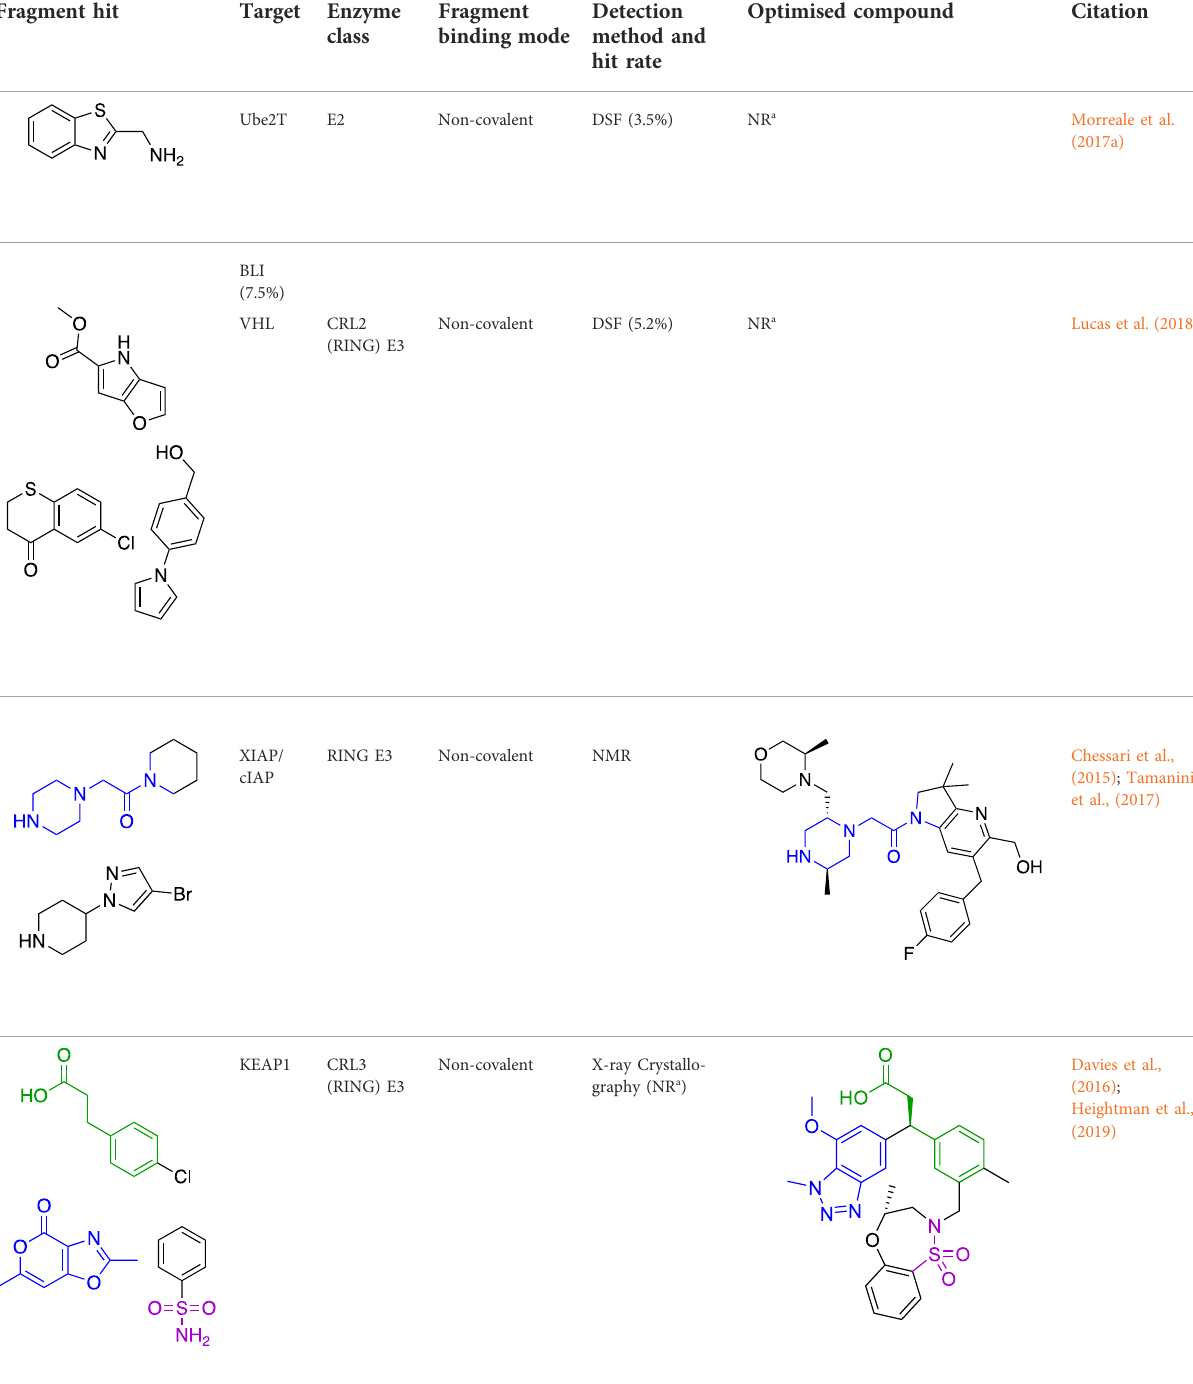
TABLE 1 Summary of fragment hits and fragment-derived modulators of ubiquitin system proteins. Pharmacophores from original fragment hits which were retained in optimised compounds are highlighted in blue/green/purple. Potency/binding af fi nity of optimised compounds was de fi ned individually in each report (see